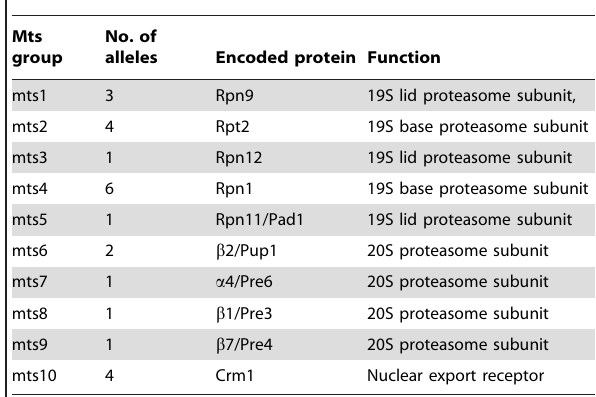
Table 2. The mts complementation